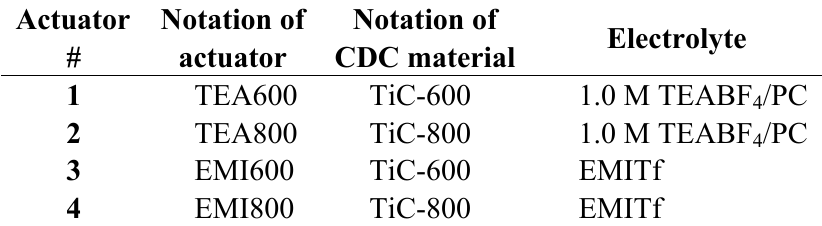
Table 1. The actuators used in this